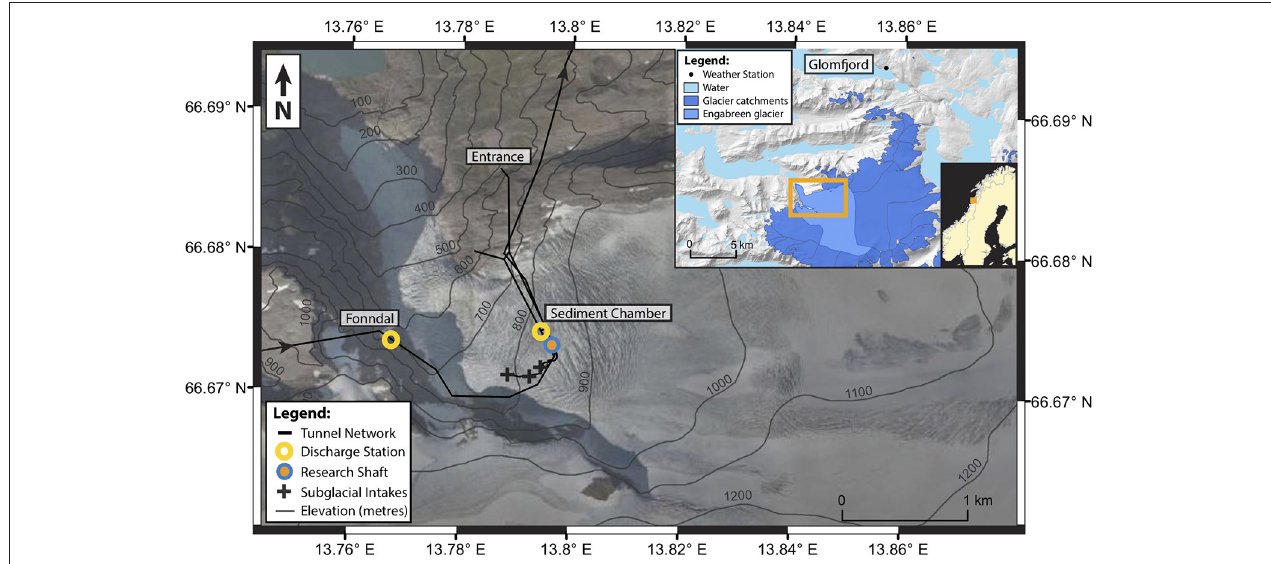
FIGURE 1 | Engabreen and the Svartisen Subglacial Laboratory, with inset showing the extent of the glacier catchment, adapted from Lefeuvre et al. (2015). The discharge measured at Fonndal and Sediment Chamber stations is used to calculate subglacial discharge collected by the subglacial intakes. The load cells are installed near the research shaft. The background satellite image is from summer 2009 (source: Statens Kartverk).